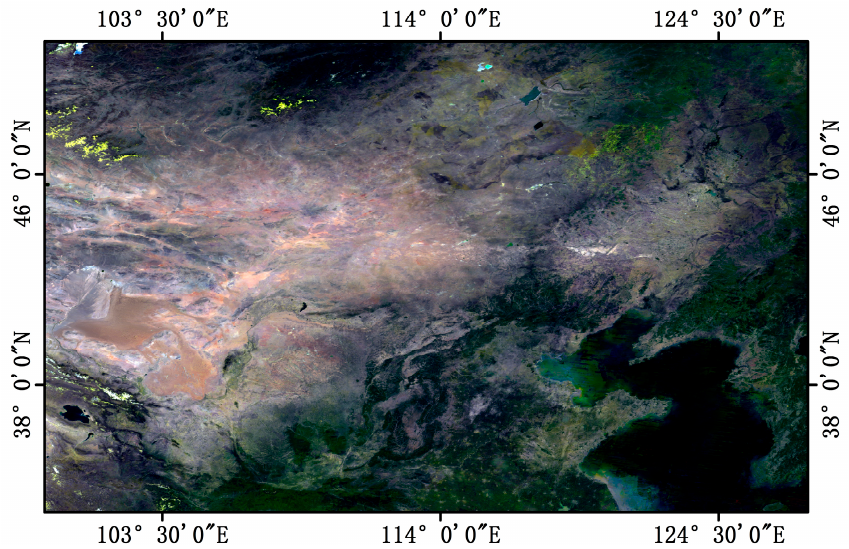
Figure 2. True color composite surface reflectance image in May 2015 using the LSR dataset.